Question: What visual encoding does this figure use to show its data?
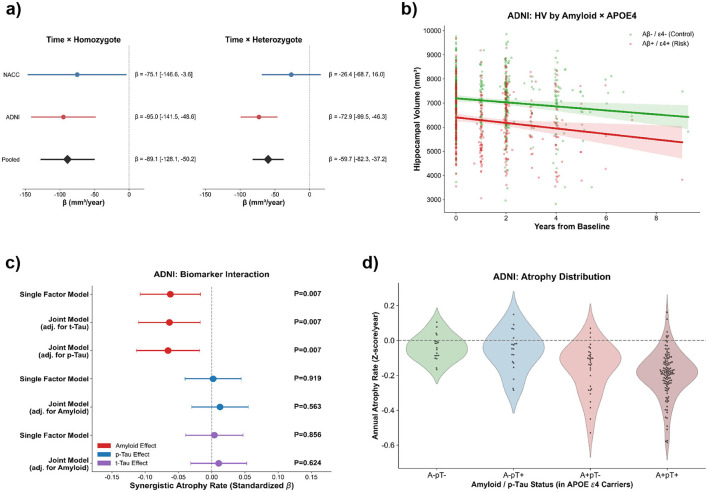
Answer: forest